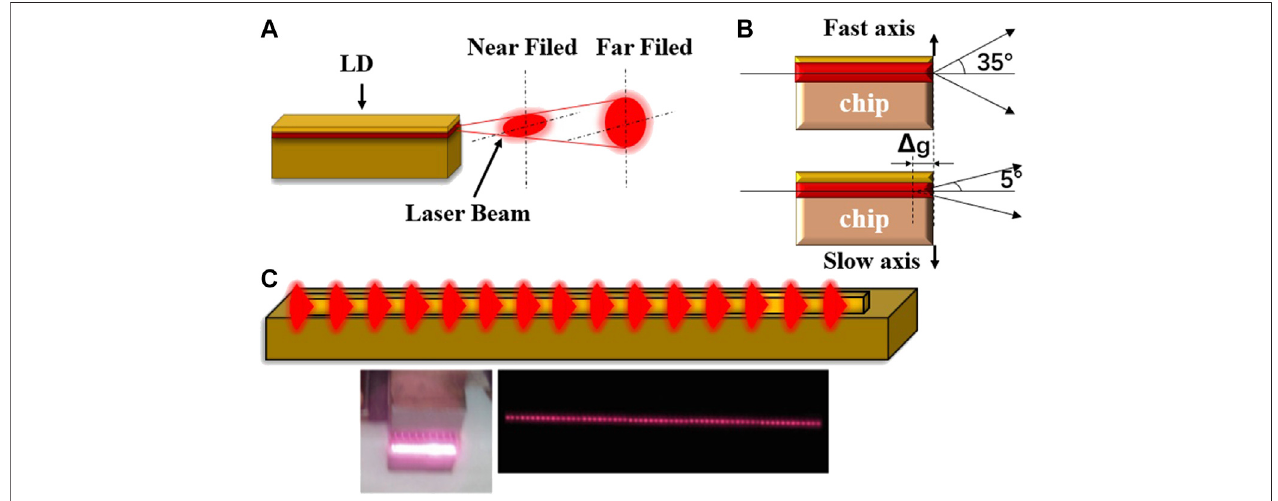
FIGURE 2 | Luminescence mechanism and disadvantage of laser diode array: (A) Light fi eld distribution diagram of laser diode; (B) Optical parameter unbalanced at two directions and astigmatism; (C) Luminous condition of laser diode array. Adapeted from [1].